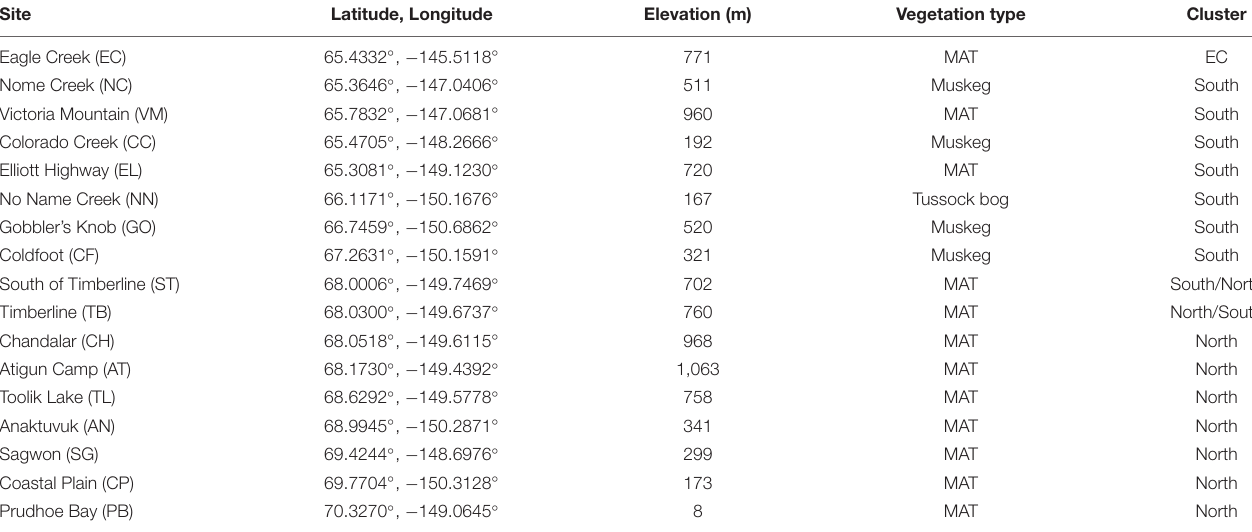
TABLE 1 | Collection sites, GPS coordinates, elevation (meters), and vegetation type of Eriophorum vaginatum in north central Alaska. Site Latitude, Longitude Elevation (m) Vegetation type Cluster